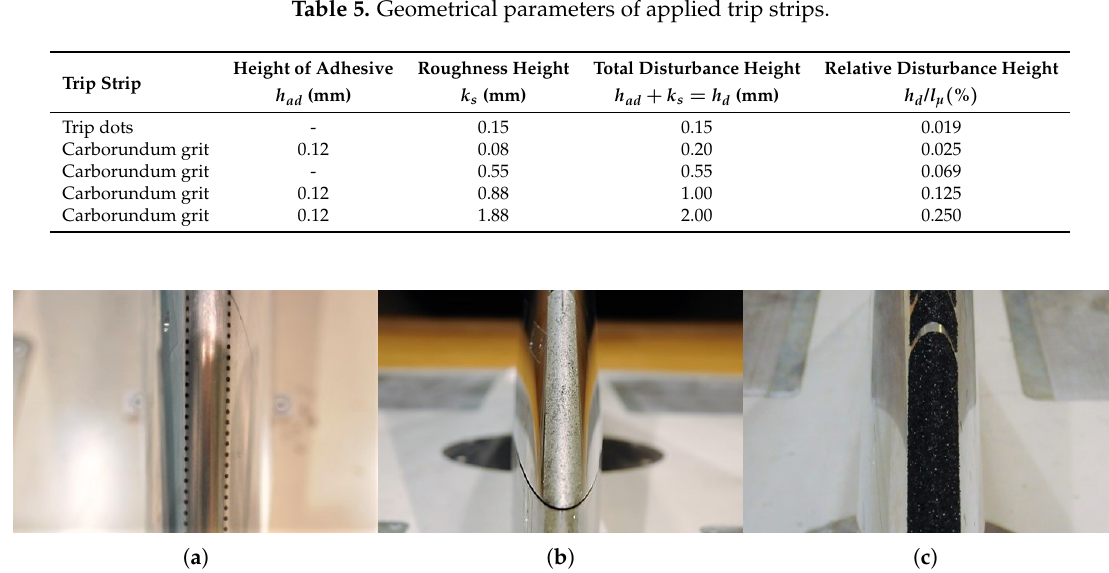
Table 5. Geometrical parameters of applied trip strips.